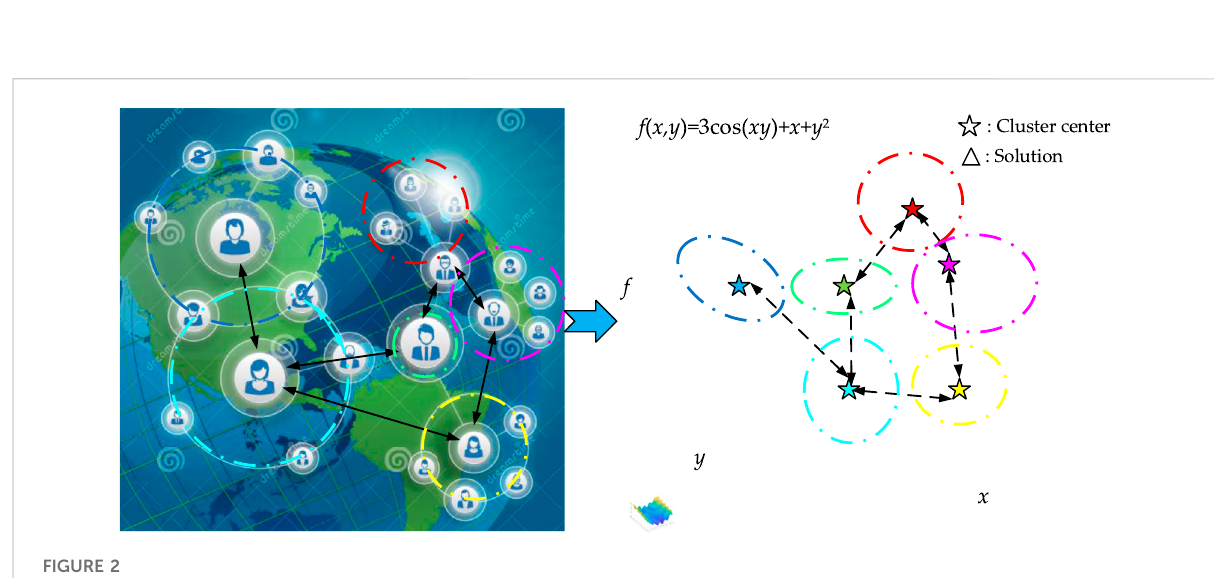
FIGURE 2 Illustration of like-attracts-like and its connection with